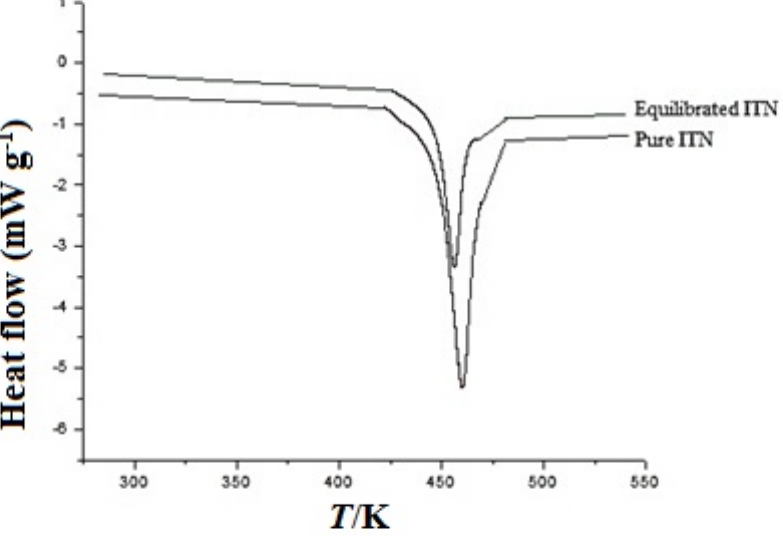
Figure 3. Differential scanning calorimetry (DSC) spectrum of pure and equilibrated ITN recovered from MeOH.